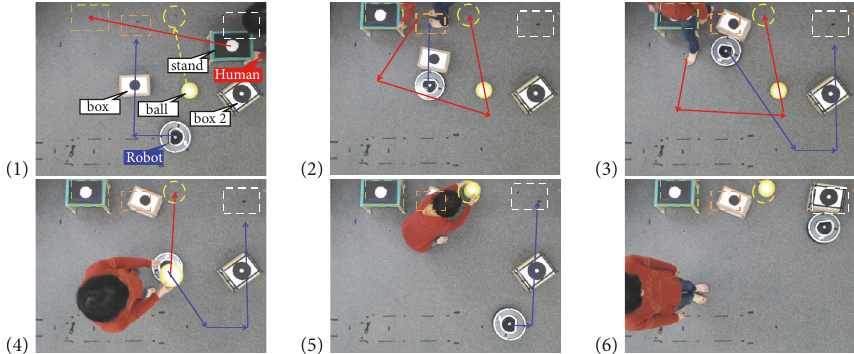
Figure 29: Experiment of the robot with a